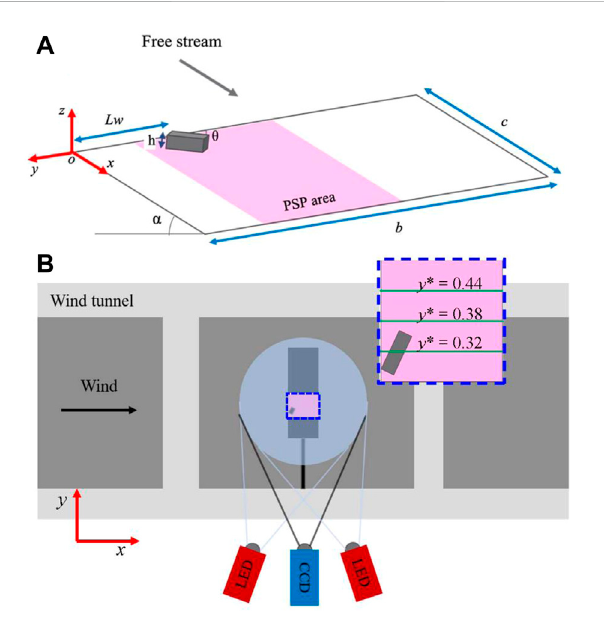
FIGURE 2 (A) Schematic diagram of the wing model with an alula-like vortex